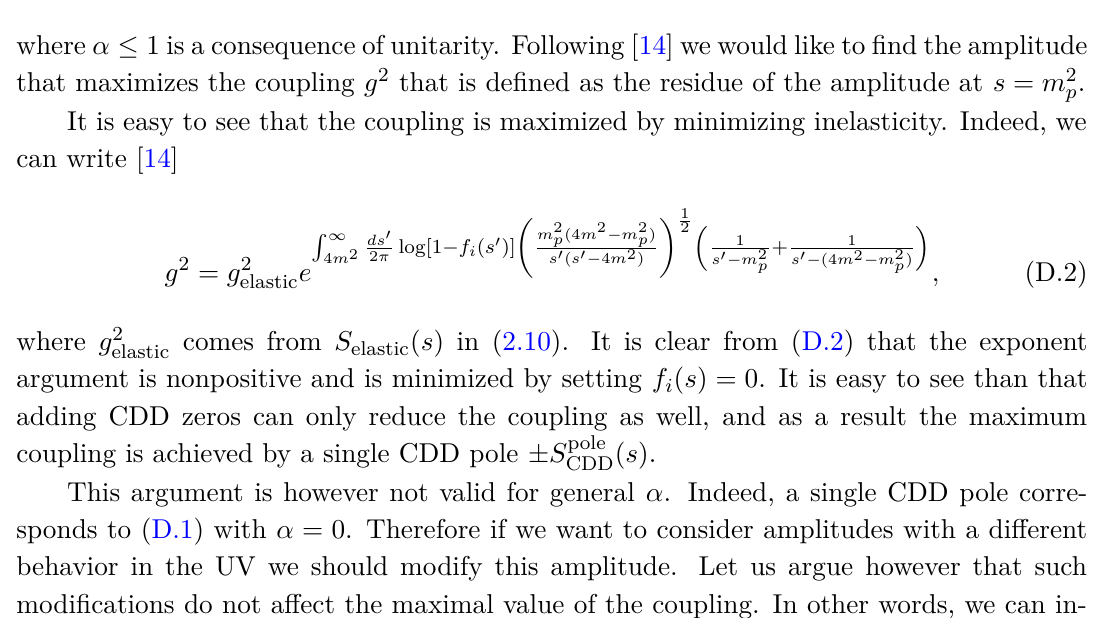
Figure 13 . Plot of bassins of attraction of Newton method applied to find the roots of p ( z ) = z 3 − 1 . In higher dimensions, an even more complicated structure is to be expected, which is consistent with what we